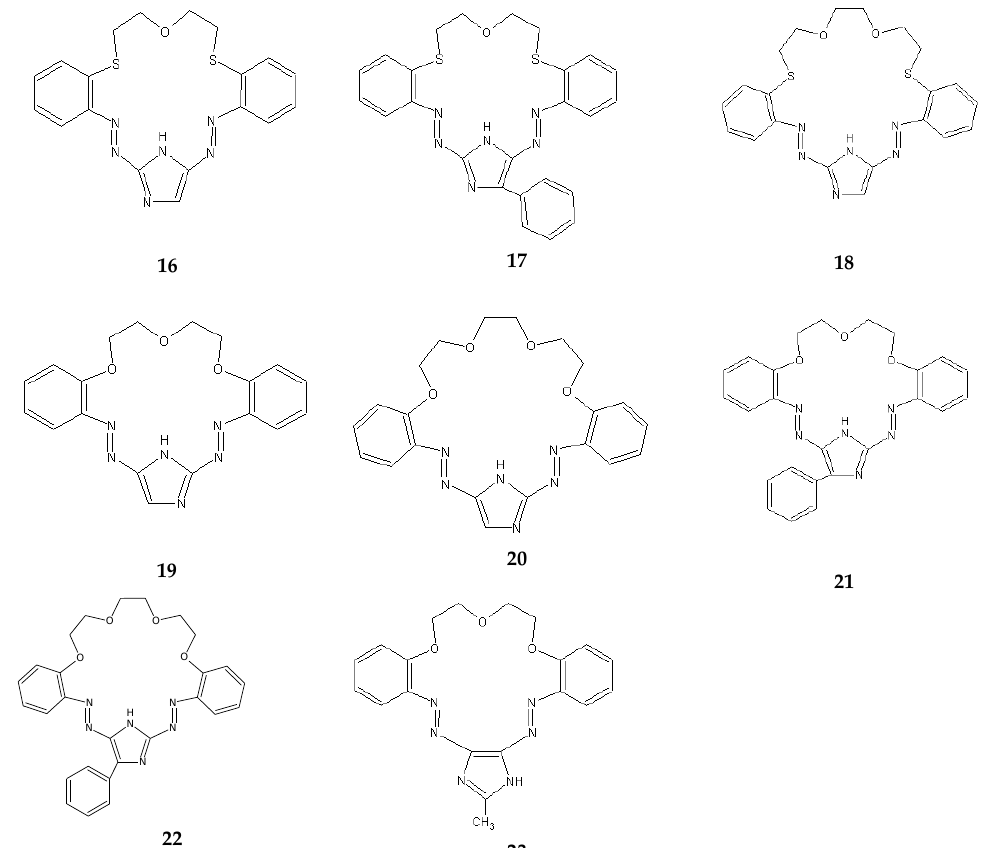
Figure 12. Imidazole derivatives of azo- and azothia-crown ethers used in the transport of metal ions across liquid membranes. across liquid